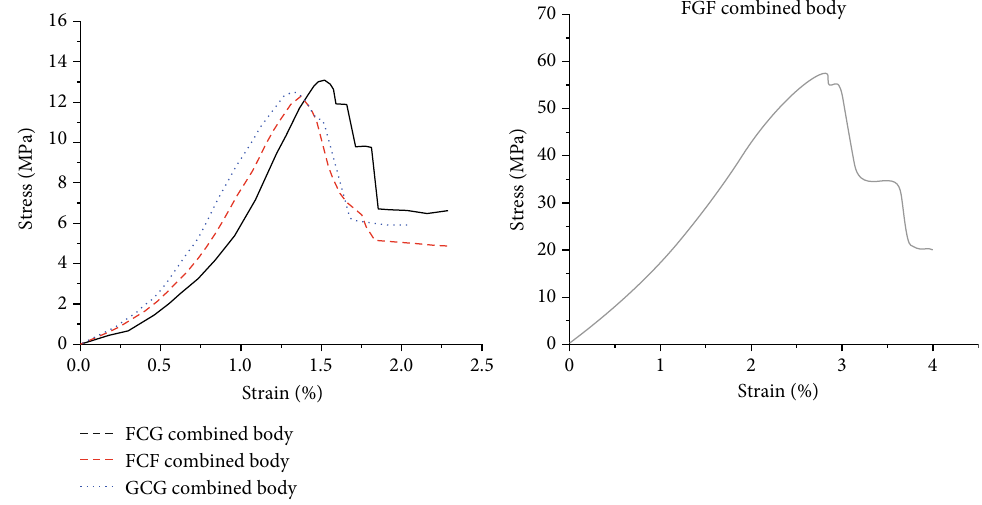
Figure 12: The most representative stress-strain curve of the combined